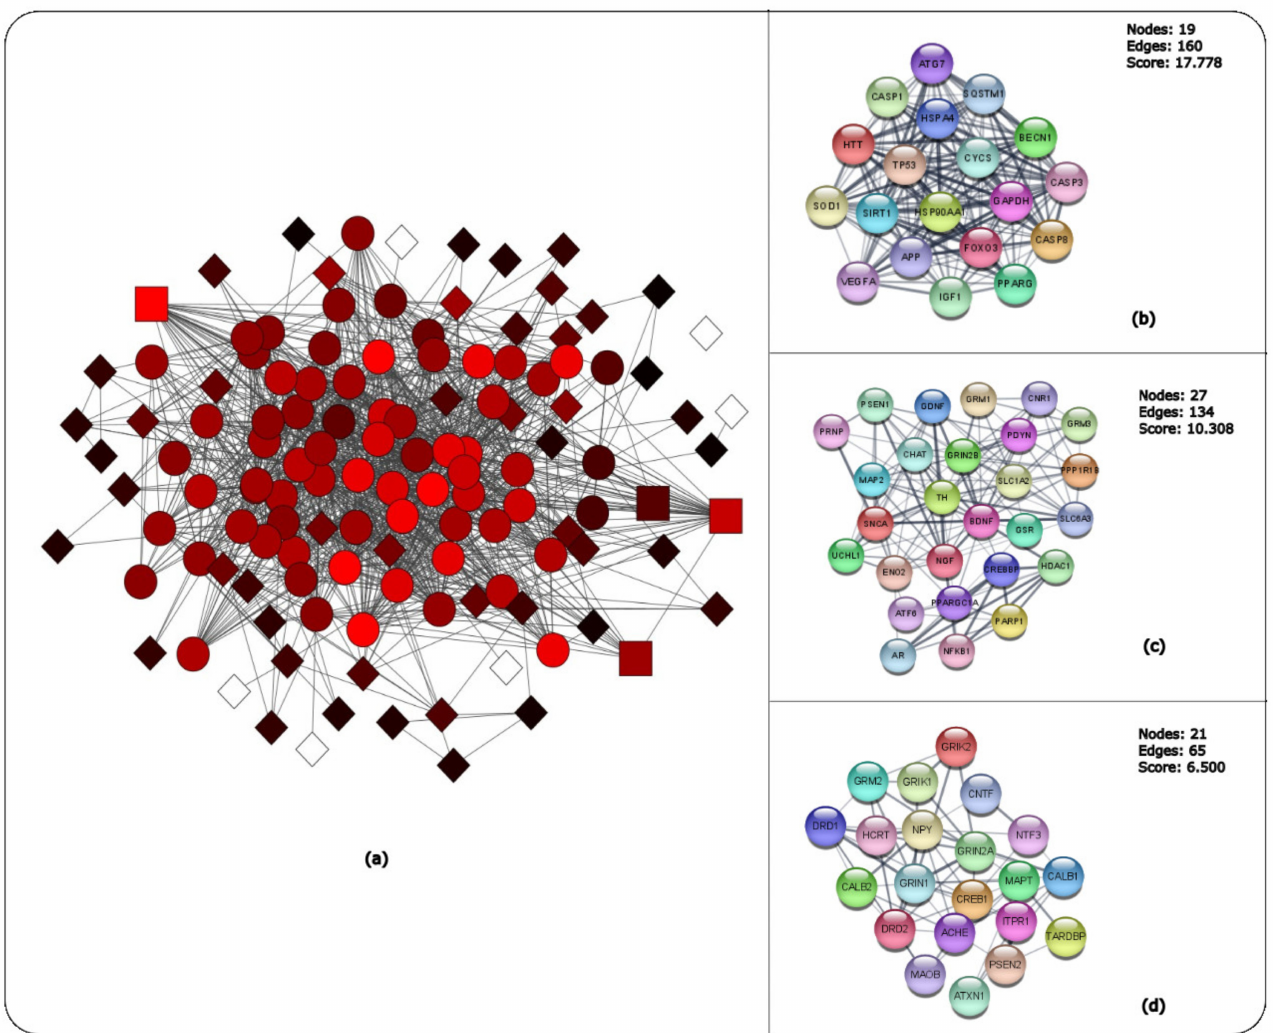
Figure 10. MCODE Cluster analysis of the 128 common genes between the three public databases. ( a ) The PPI of the 128 common genes visualized and analysed in MCODE, highlighting the three clus- ters. Square nodes represent seeds with the highest score, circle nodes represent clustered nodes and diamond nodes represent unclustered node. Black to red MCODE nodes represent lowest- to highest-scoring nodes and white-coloured nodes represent zero MCODE score. Subnetworks indicating ( b ) cluster 1 ( c ) cluster 2 and ( d ) cluster 3